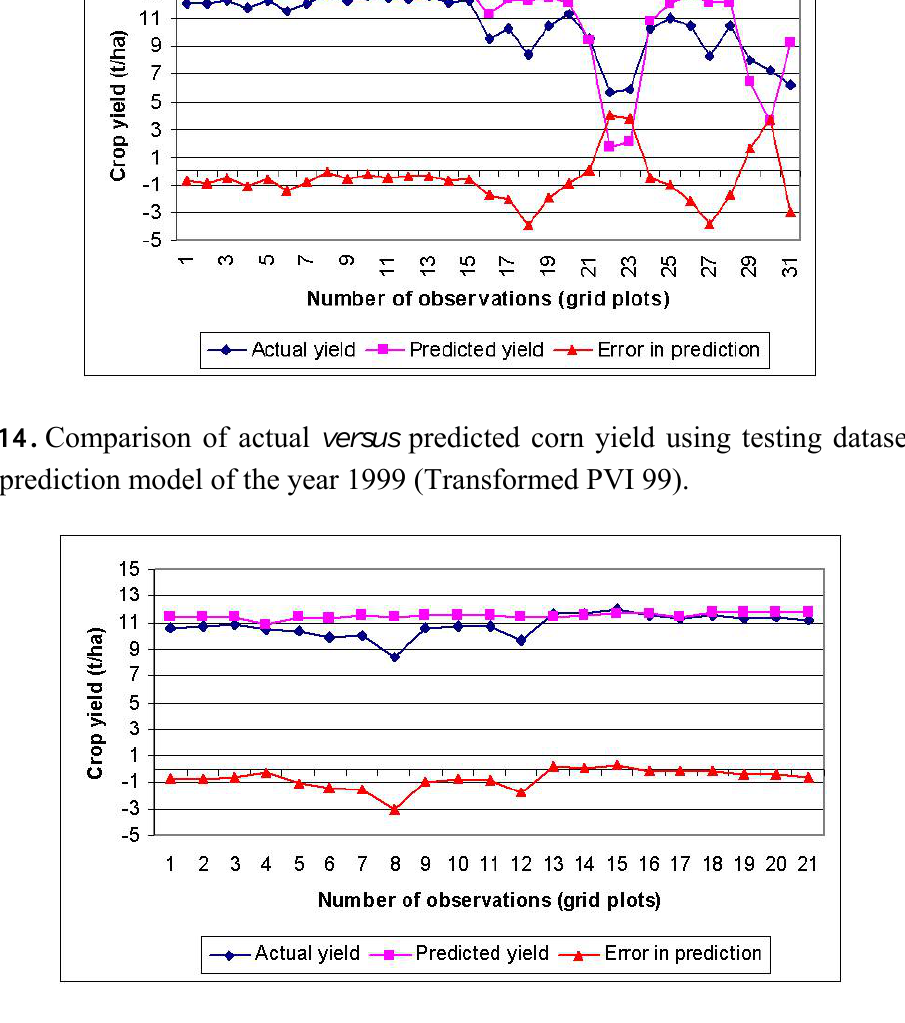
Figure 15. Comparison of actual versus predicted corn yield using testing dataset of the optimal prediction model of the year 2001 (Transformed PVI